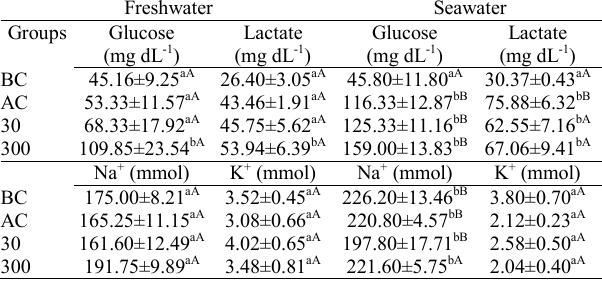
for all groups at the end transport (range of groups: 2.18-3.28 /